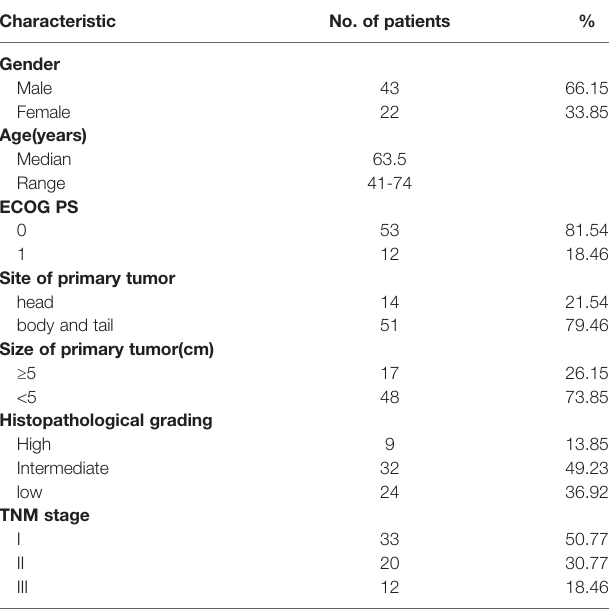
TABLE 1 | Patient